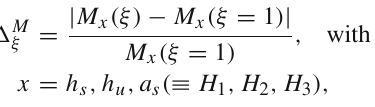
Fig. 15 (upper plot) the gauge-parameter dependence of the (red lines), of CP-even singlet-like Higgs-boson mass M h s (blue lines), and of the the SM-like Higgs-boson mass M h u (black lines). The CP-odd singlet-like Higgs-boson mass M a s calculation is performed up to the two-loop order including ) corrections.Thefulllines(dashed-lines)are the O (α t α s + α 2 t obtained using the OS (DR) renormalization scheme in the top/stop sector. The lower plot displays the relative difference between the mass calculated in a general R ξ gauge, M x (ξ) , and in the ’tHooft–Feynman gauge ξ = 1, M x (ξ = 1 )